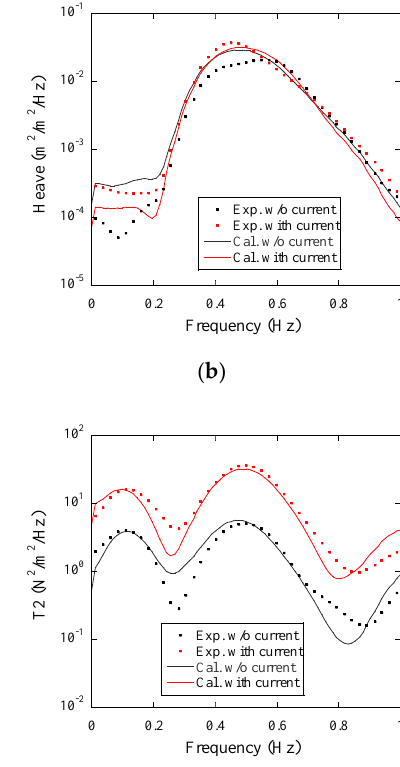
Figure 13. PSD of measured wave elevation.